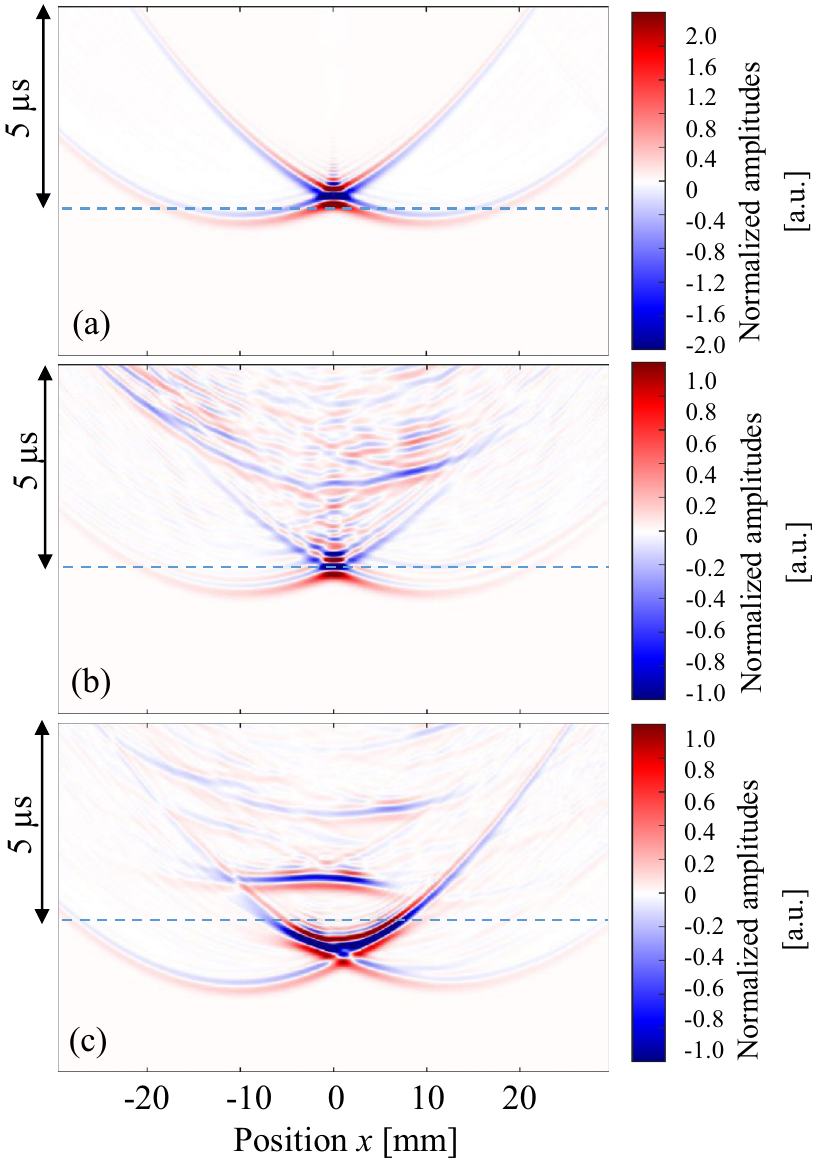
Figure 5. Observed waves at different positions. Ultrasonic waves propagated through ( a ) water only, ( b ) the empty model and ( c ) the uniform model. Dashed line indicates the arrival time of the wave which passed through water